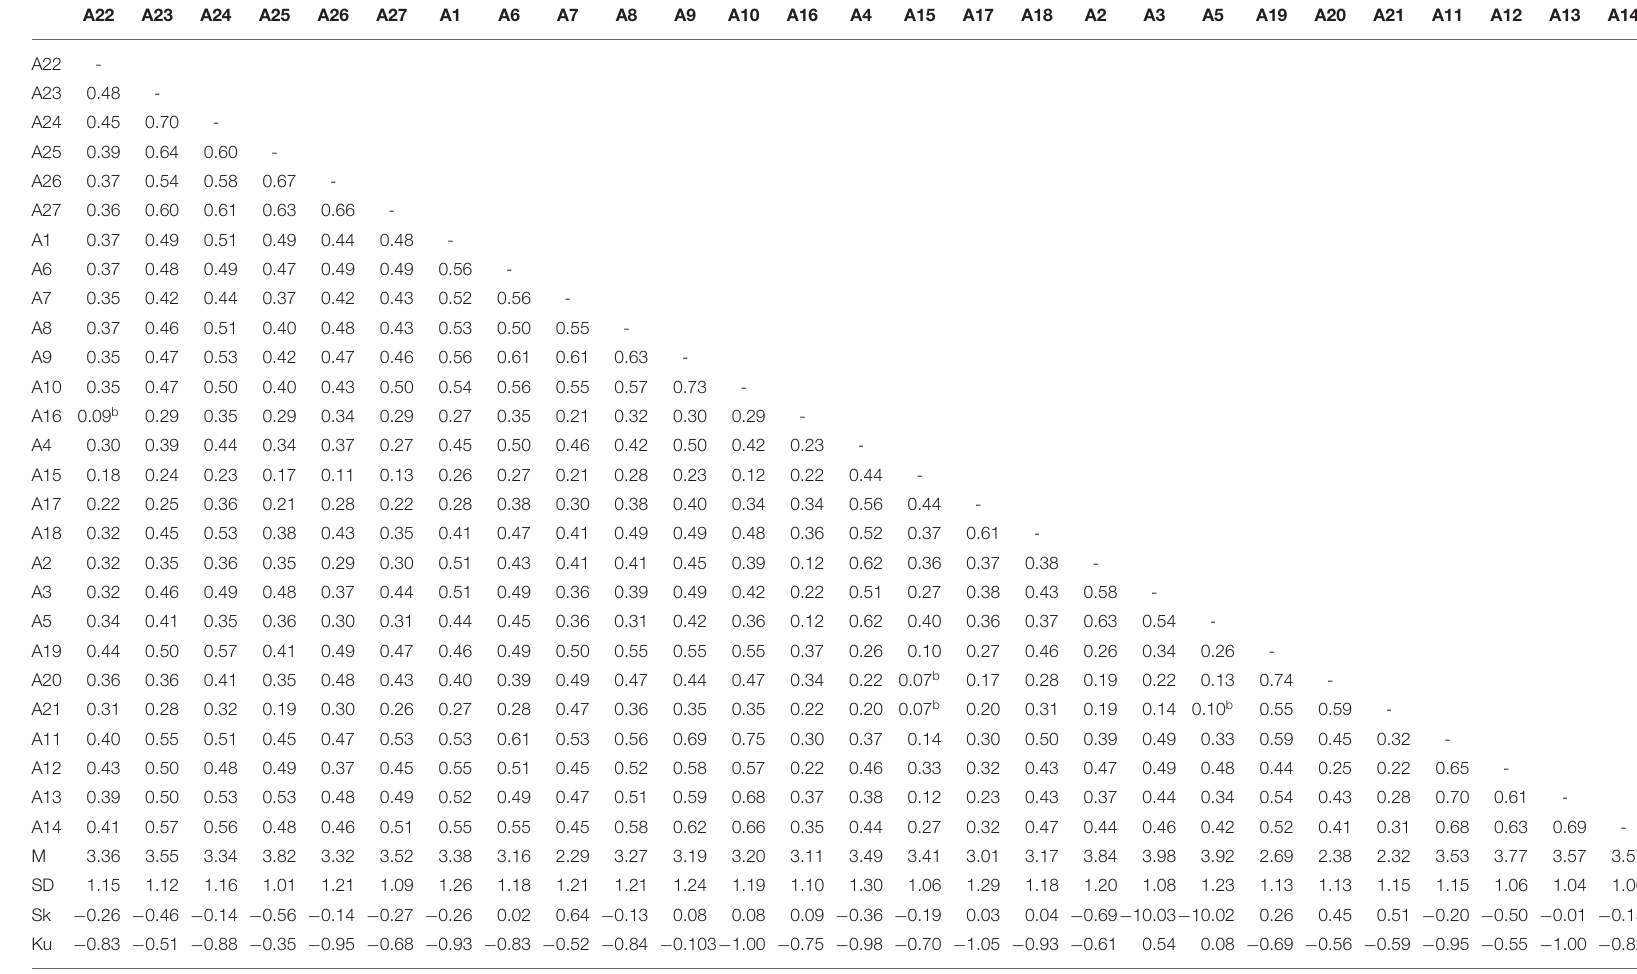
TABLE 2 | Correlation and description for the EOQ